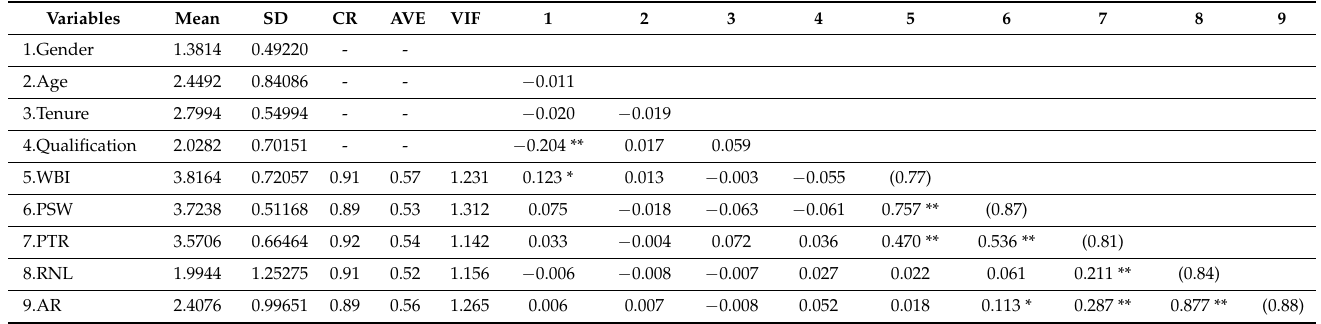
Table 3. Mean, Standard Deviation, Correlations and Reliability (N = 354).